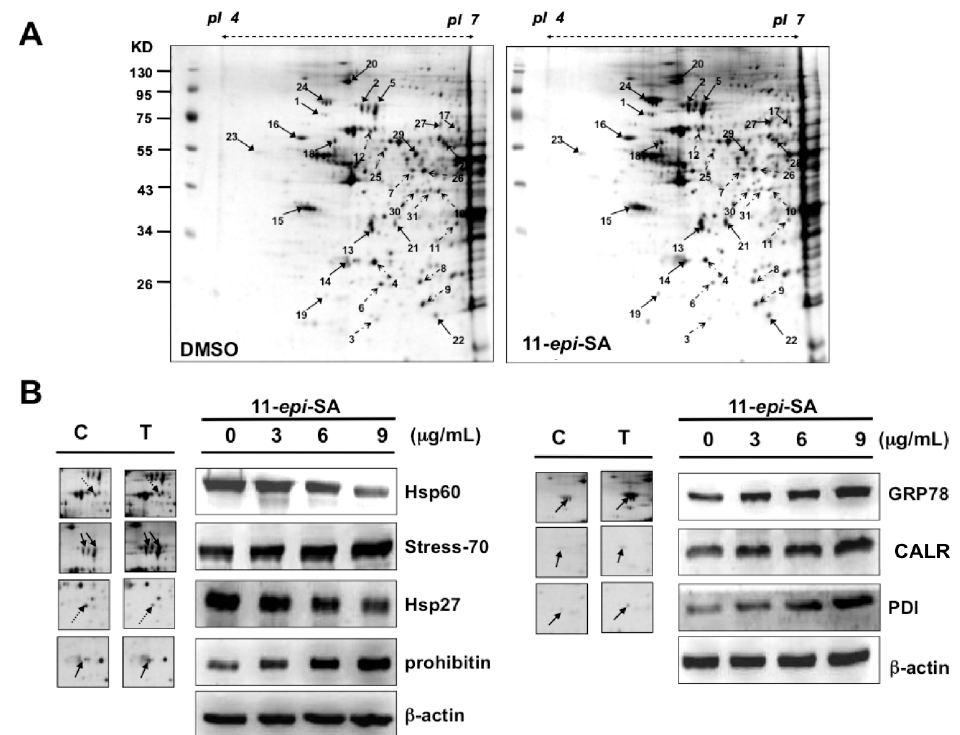
Figure 5. Identification of differentially expressed proteins from mock- and 11- epi -SA-treated HA22T hepatoma cells by two-dimensional gel electrophoresis (2DE) . ( A ) HA22T cells treated with DMSO (control) or 11- epi -SA at the concentration of 9 μ g/mL for 24 h, were harvested and cell lysates were prepared as described in the Materials and Methods section. One hundred micrograms of protein were subjected to 2DE, and the proteins were visualized by silver staining. PDQuest image analysis software (Bio-Rad) was used for detecting the differential protein spots; ( B ) Validation of identified selected proteins from 2DE. The cell lysates prepared from mock- and 11- epi -SA-treated cells were subjected to sodium dodecyl sulfate polyacrylamide gel electrophoresis (SDS-PAGE) for protein separation. Some identified proteins including glucose-regulated protein 78 (GRP78)/binding immunoglobulin protein (Bip), calreticulin (CALR), protein disulfide isomerase (PDI), 60 kDa heat shock protein (Hsp60), stress-70, 27 kDa heat shock protein (Hsp27), and prohibitin were detected by Western blotting by using specific antibodies as indicated. C: control, DMSO-treated cells; T: 11- epi -SA-treated cells. β -actin was used as the loading control.